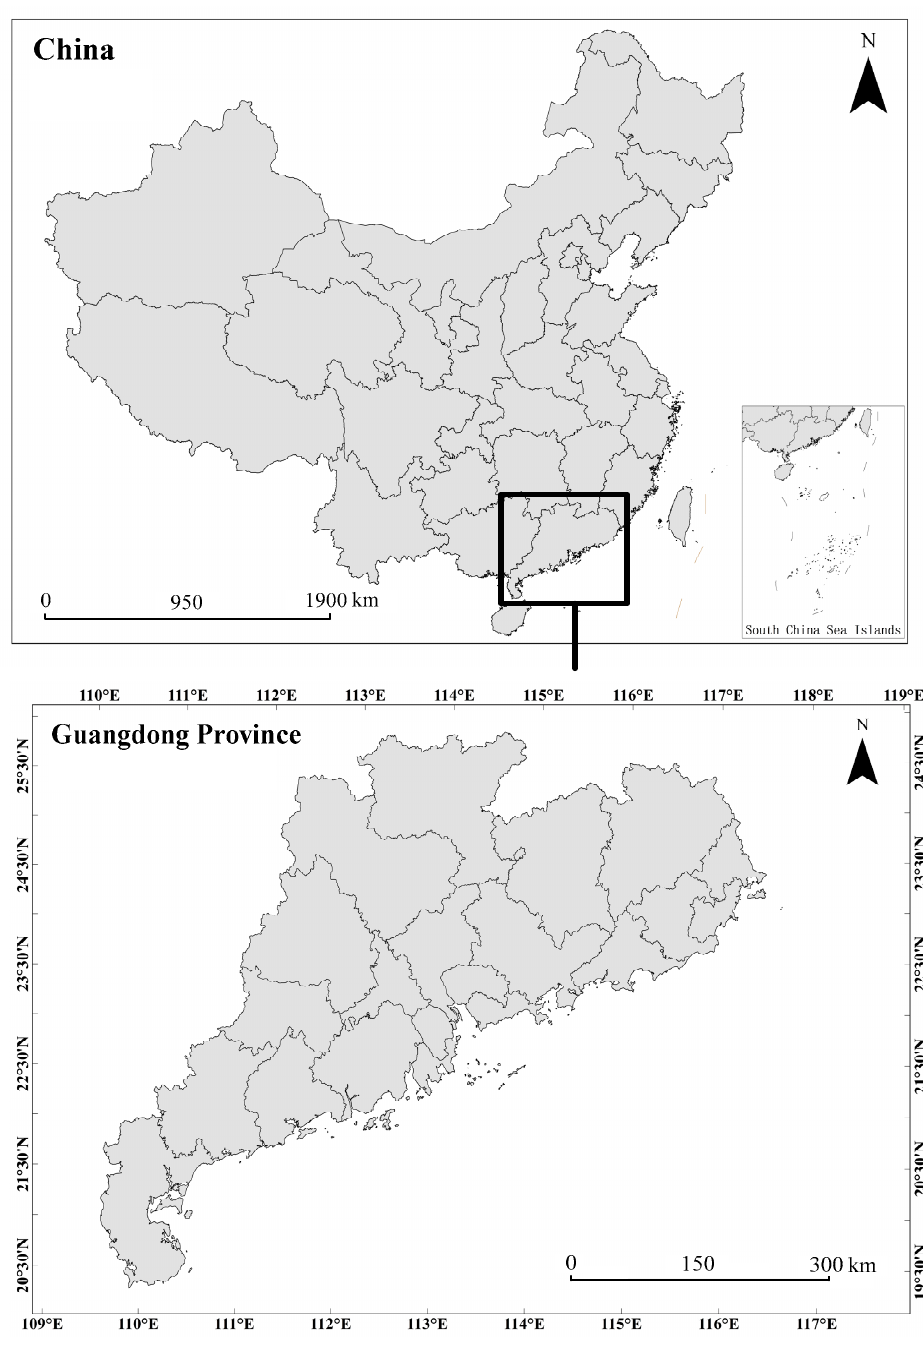
Figure2. Map of study area. Figure 2. Map of study